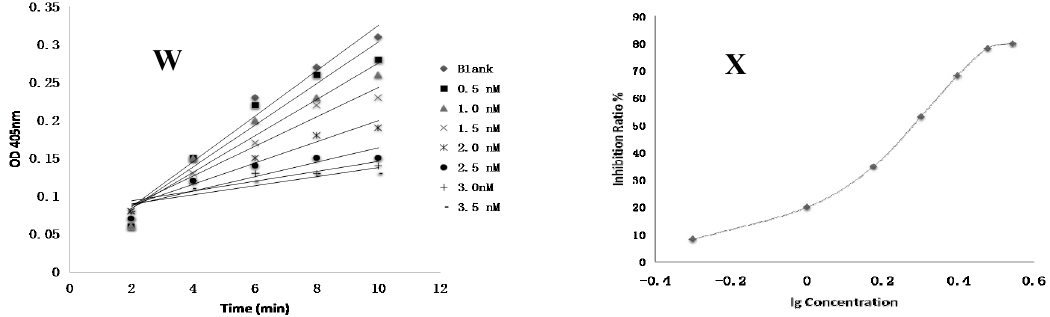
Figure 4. The inhibition profile figures against coagulation factor X. ( A , B ) Rg1; ( C , D ) Rh1; ( E , F ) Rg2;